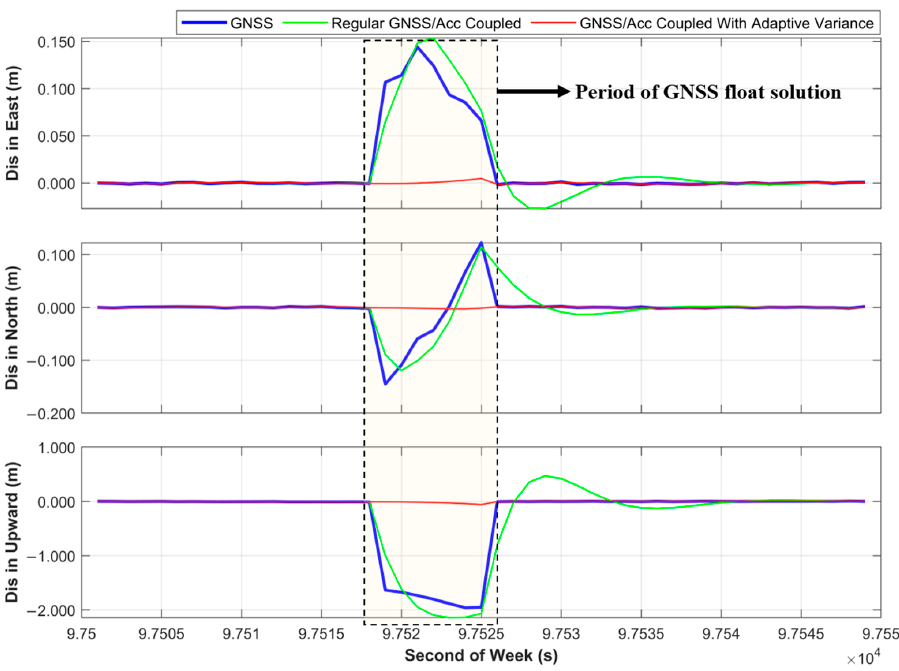
Figure 7. The relationship between the base station outage duration and the covariance.